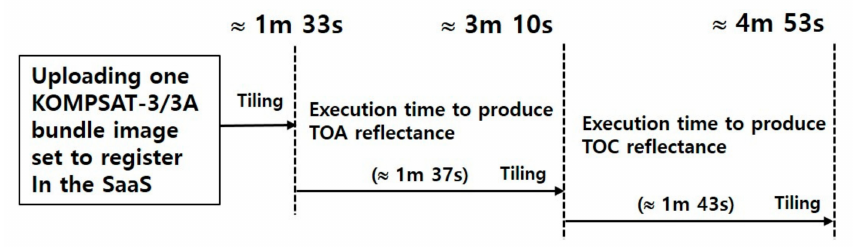
Figure 9. Result of the performance test of the SaaS execution